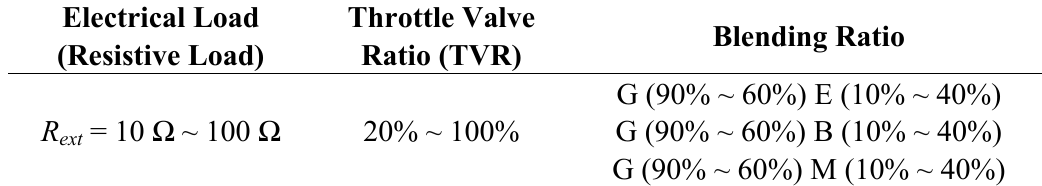
Table 4. Measurement parameter ranges.